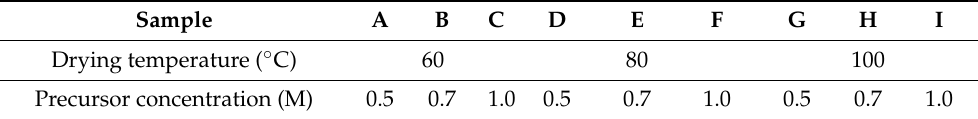
Table 1. Conditions for film deposition.